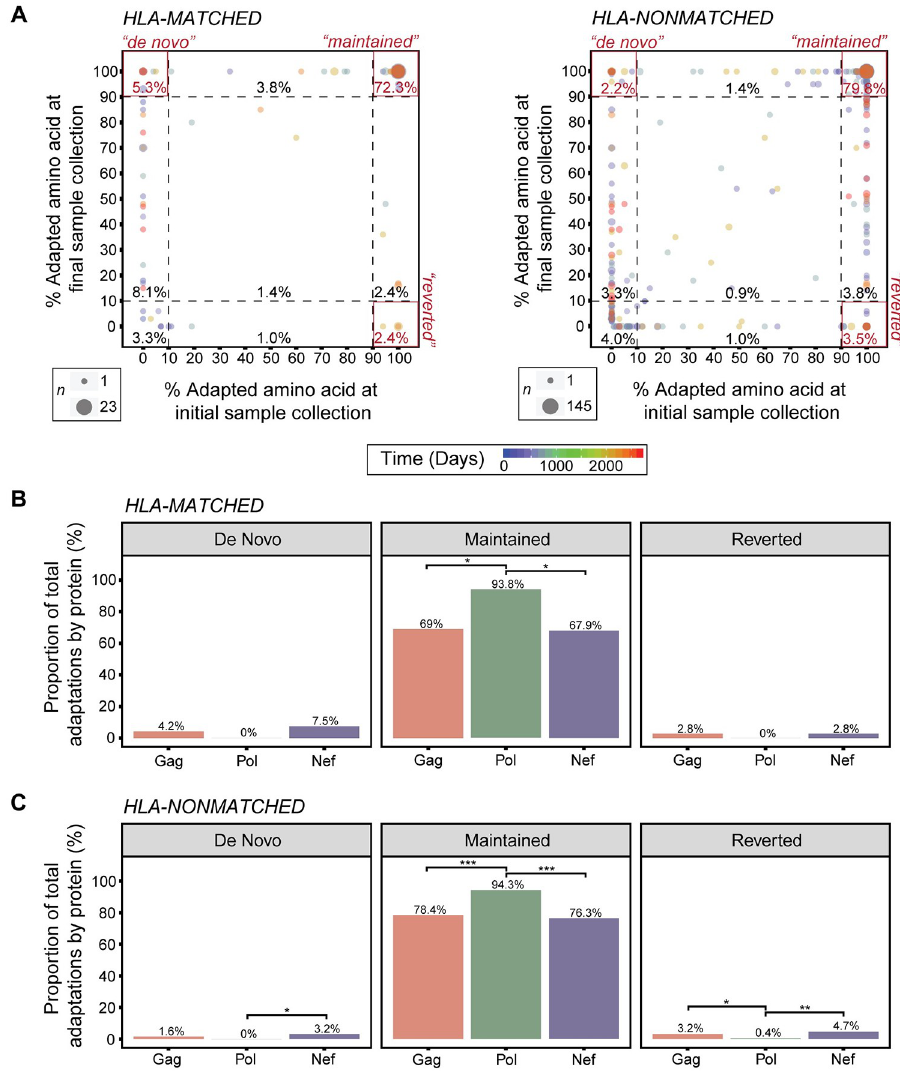
Fig 3. High proportion of viral adaptations are present early and retained over time. A) Adaptation dynamics between initial and final sample collection suggests that most HLA-matched adaptations (adaptations associated with host HLA class I alleles; 209 total adaptations) and HLA-nonmatched adaptations (adaptations not associated with host HLA class I alleles; 1702 total adaptations) are retained over time at � 90% frequency in the viral quasispecies. Each point reflects a single HLA-associated HIV-1 adaptation. Size of each point displays the degree of superimposition of points. Color reflects the time in days between initial and final sample collection. Percentages indicate the proportion of total HIV-1 adaptations located within each quadrant. B) Comparison between proteins for the proportion of de novo , maintained and reverted HLA-matched adaptations over time (71, 32 and 106 adaptations examined for Gag, Pol and Nef, respectively). A significantly greater proportion of maintained adaptations in Pol was identified, compared to Gag ( � , p = 0.025) and Nef ( � , p = 0.022). However, no difference in the proportion of de novo or reverted adaptations between proteins was identified. C) HLA-nonmatched adaptations were also compared by protein (498, 281 and 923 adaptations examined for Gag, Pol and Nef, respectively). In this category, Pol exhibited a significantly reduced proportion of de novo adaptations compared to Gag ( � , p = 0.013) and reverted adaptations compared to Gag ( � , p = 0.036) and Nef ( �� , p = 0.004). However, Pol exhibited a significantly greater proportion of maintained adaptations compared to Gag ( ��� , p < 0.001) and Nef ( ��� , p < 0.001). Analyses in (B) and (C) using three-sample test for equality of proportions and Holm-corrected pairwise comparison of